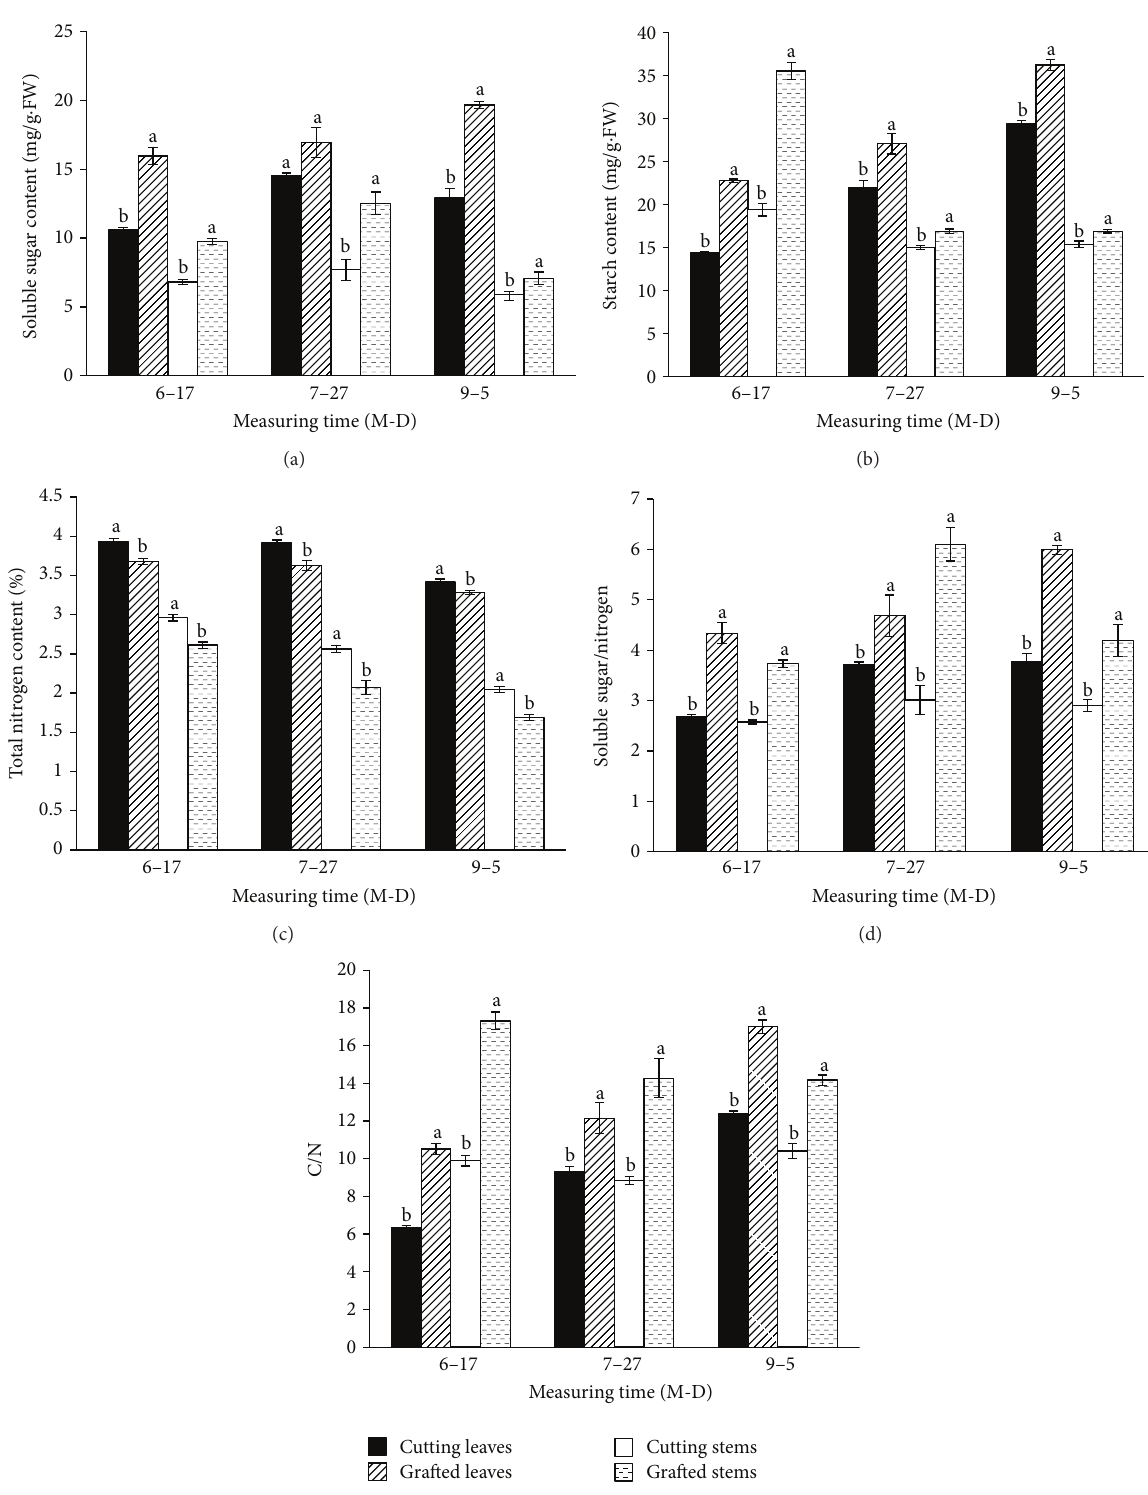
Figure 2: The contents of soluble sugar, starch, and total nitrogen, soluble sugar/nitrogen, and C/N in the nongrafted and grafted cuttings. H1, cuttings harvested on June 17; H3: cuttings harvested on July 27; H5: cuttings harvested on September 5; means and standard errors calculated from three replicates Significance ( 𝑃 < 0.05 ) indicated by lower case lettering ((a), (b)), derived using the Duncan’s multiple range